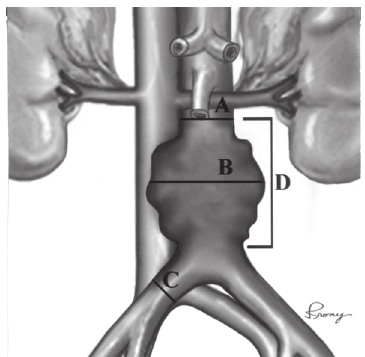
Figure 1 - Schematic representation of aneurysm measurement.